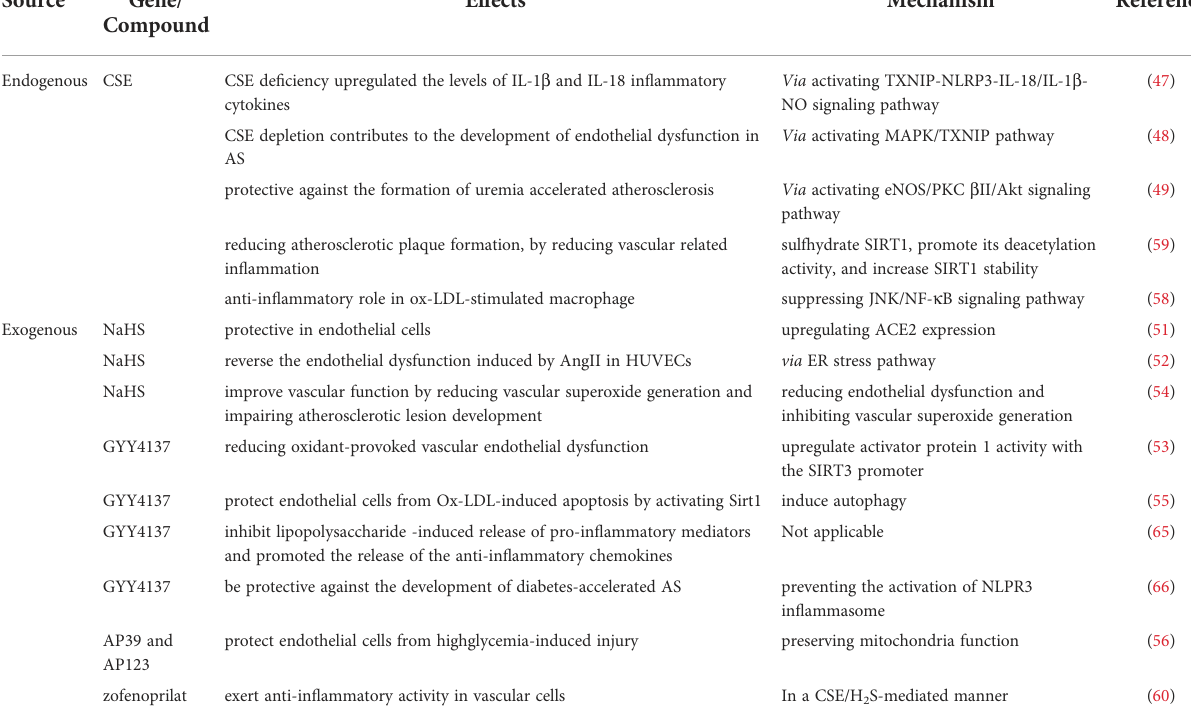
TABLE 2 Effects of Endogenous H 2 S and Exogenous H 2 S in AS. Gene/